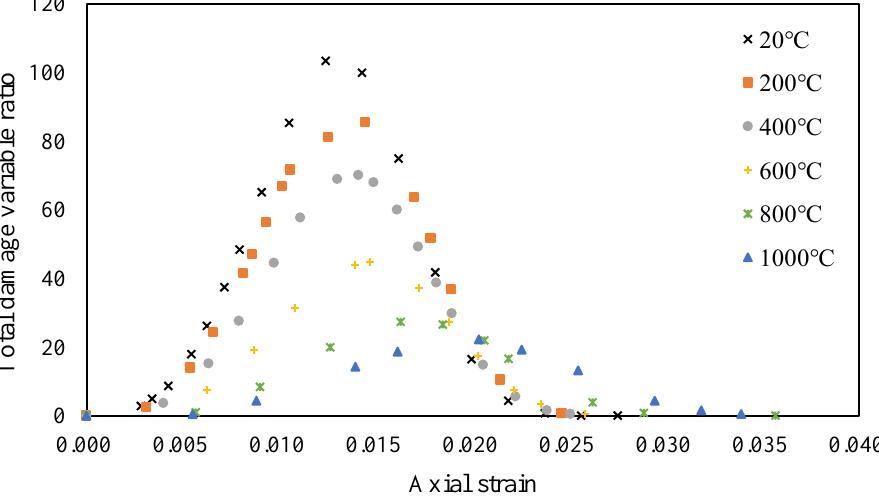
Figure 6. The total damage evolution ratio of granite after heat